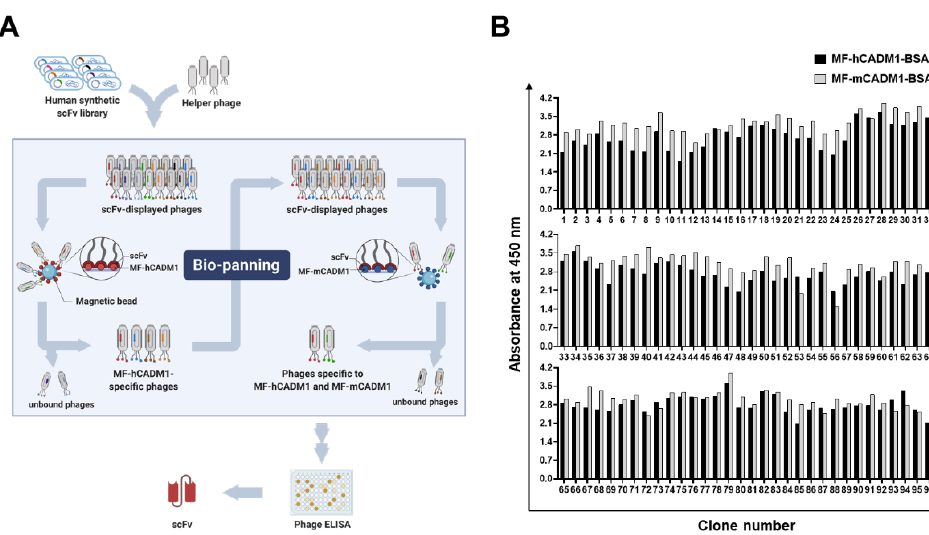
Figure 2. Selection of human and mouse MF-CADM1-specific scFv clones using phage display technology. ( A ) Schematic representation of the scFv antibody selection procedures using phage display bio-panning. Six rounds of bio-panning were performed with the MF-hCADM1- or MF-mCADM1-BSA-immobilized magnetic beads. ( B ) Phage ELISA, with 96 randomly selected phage clones, was performed to select MF-hCADM1- and MF-mCADM1-specific scFv clones.